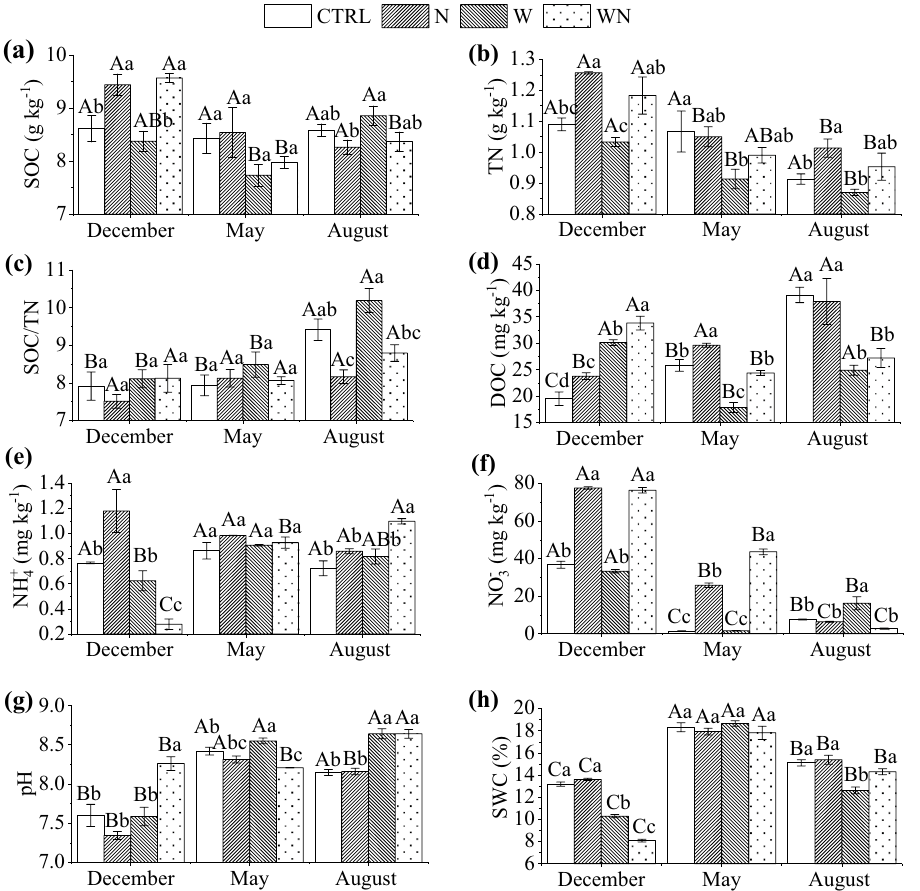
Figure 1. Effects of long-term warming (W), nitrogen fertilization (N) and their combination (WN) on soil physico-chemical properties. Small letters show significant differences between treatments in the same sampling time. Capital letters show significant differences between sampling times in the same treatment at 95% confidence level (n = 3, p < 0.05). The abbreviations are the same as in Table